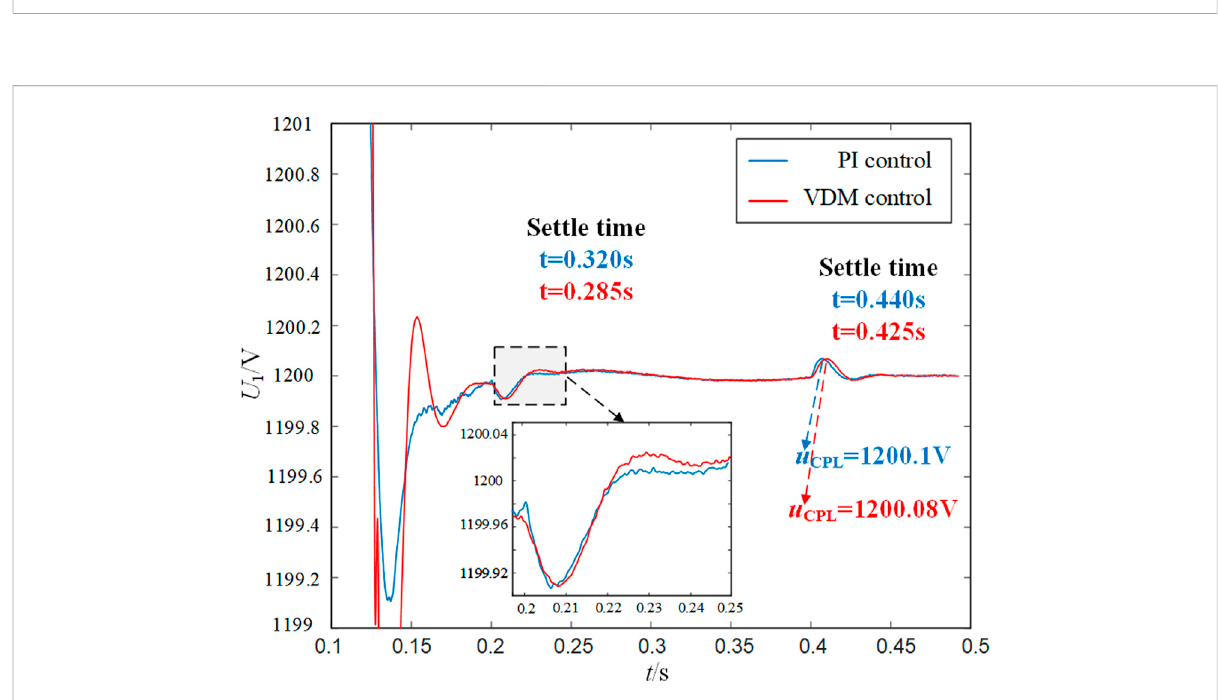
FIGURE 15 Comparison diagram of DC bus voltage under CPL load fault